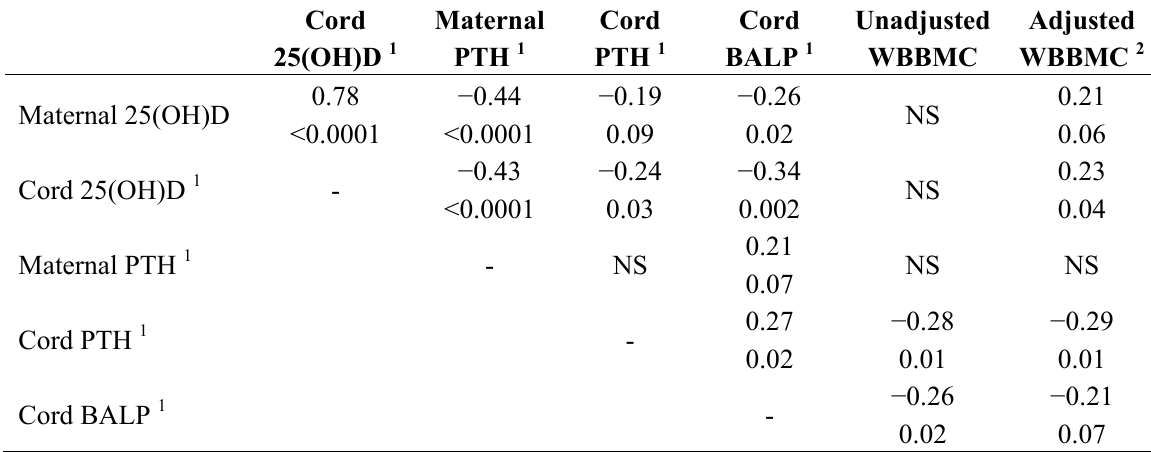
Table 1. Correlations between parameters (Pearson’s correlation coefficient and p